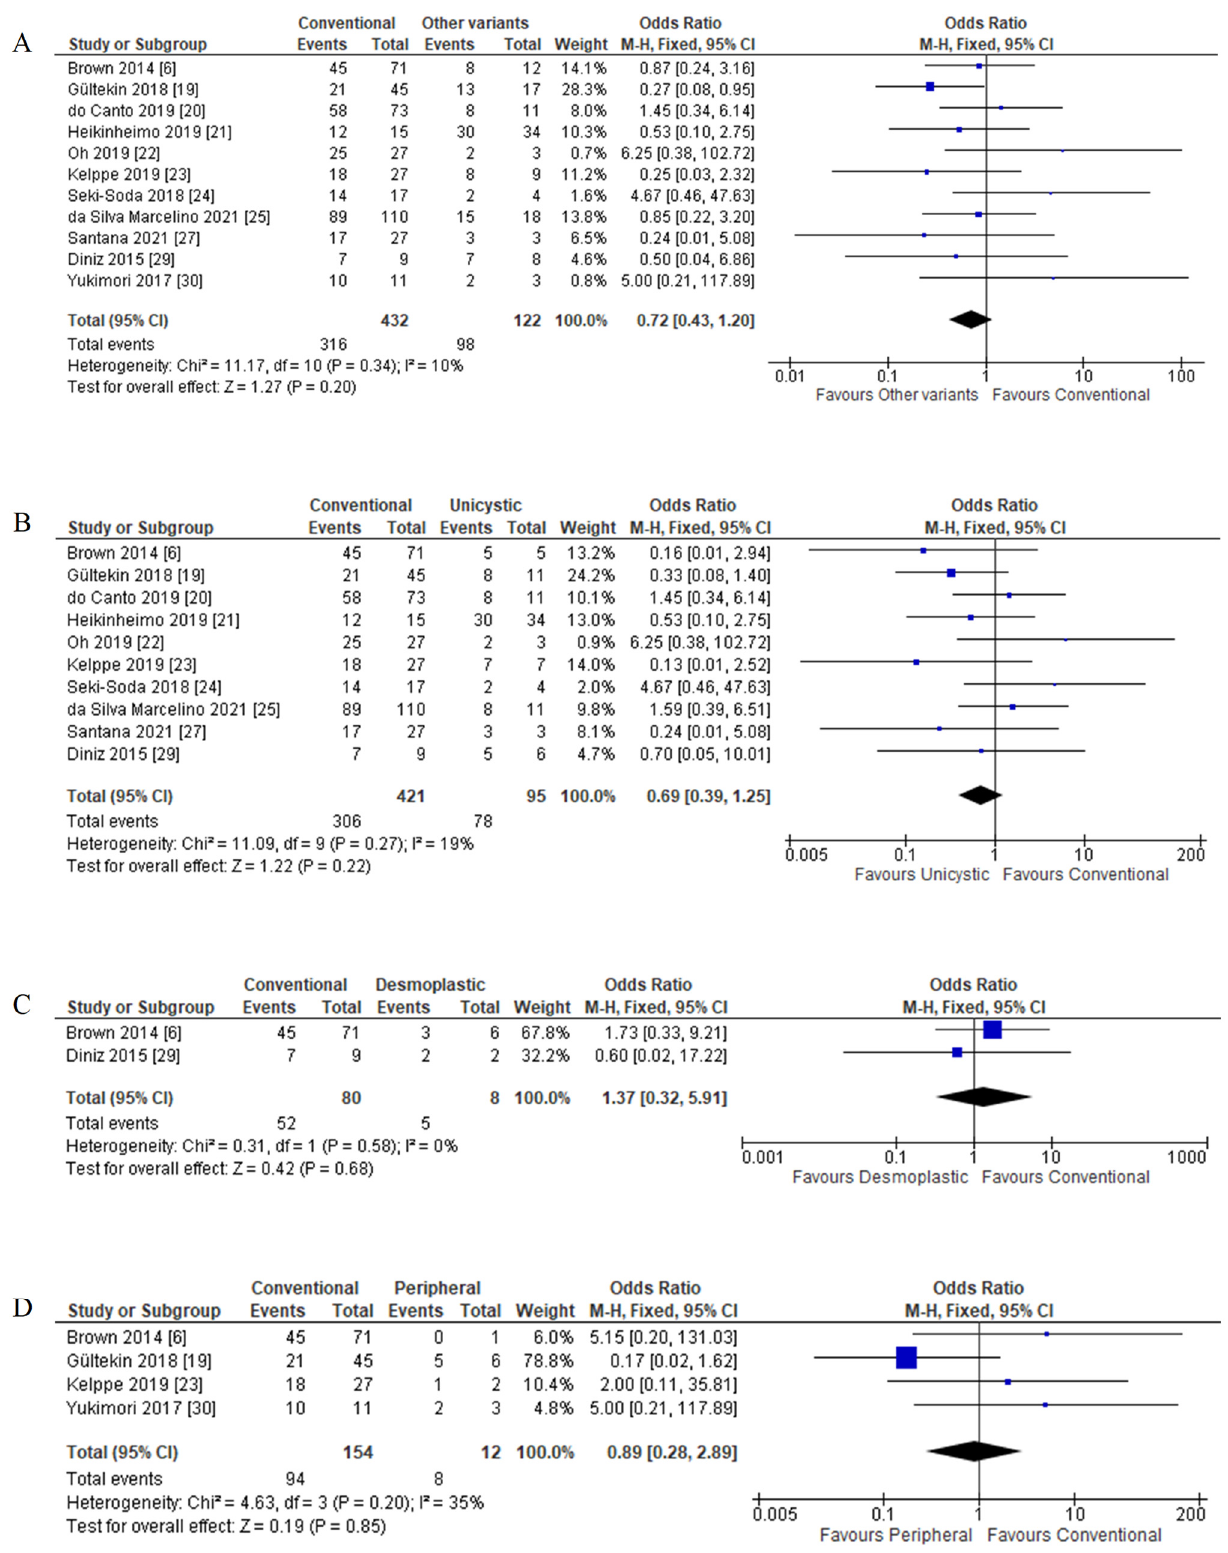
Figure 6. Forest plot of histological variants association with BRAF V600E mutation in ameloblastoma cases. ( A ) Conventional versus other variants; ( B ) conventional versus unicystic; ( C ) conventional versus desmoplastic; ( D ) conventional versus peripheral.